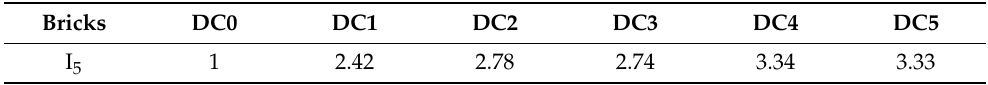
Table 4. Natural fibers used for bricks and tensile strength of earth bricks. Table 5. Toughness index for bricks with dynamic